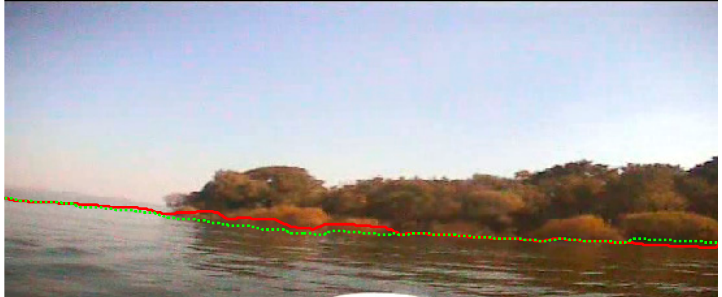
Figure 22. Precision validation of our method. The green dot line is the ground truth; the red solid line is the detection result of our method in this paper.